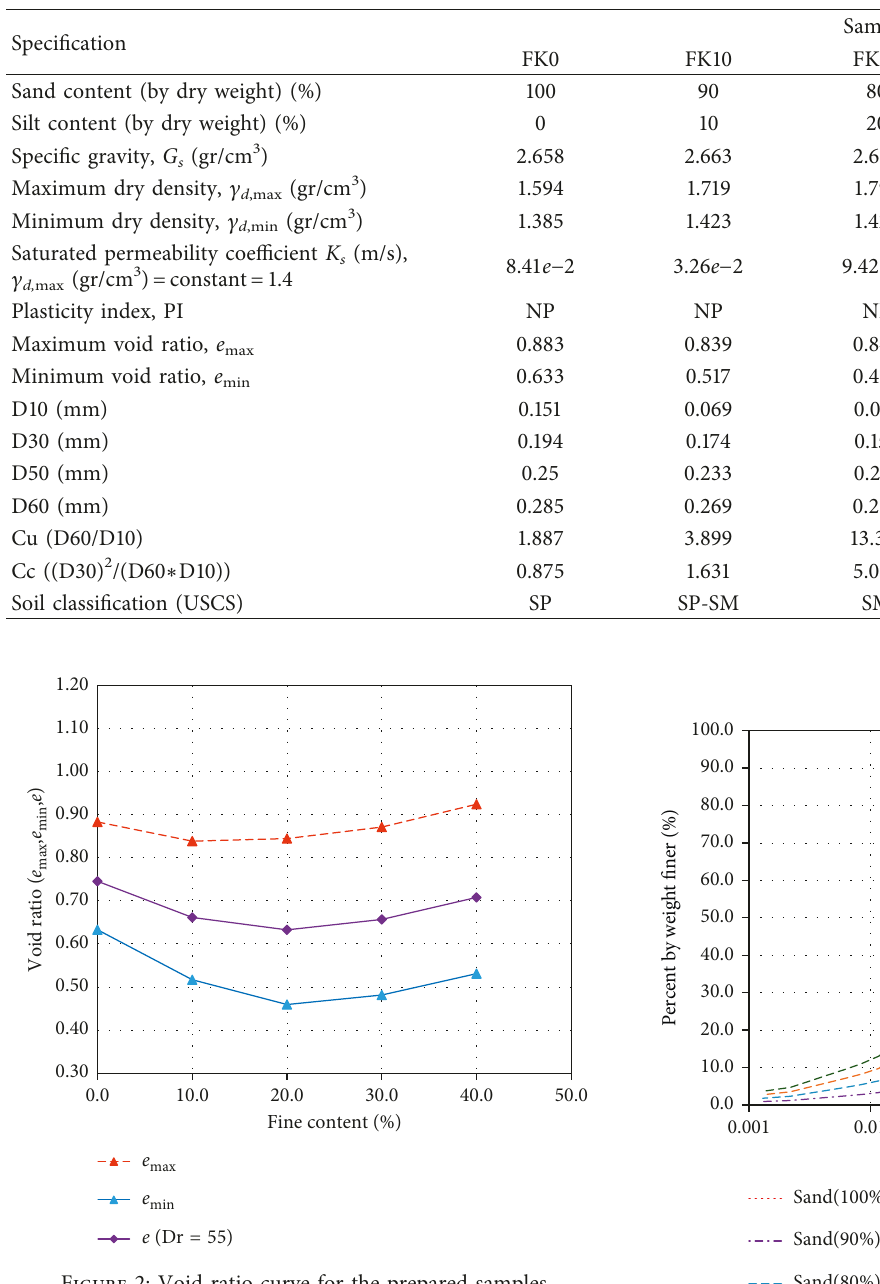
Table 2: Basic properties of the studied soil samples.